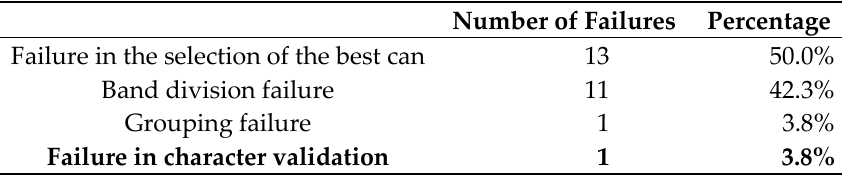
Table 2. List of causes of test